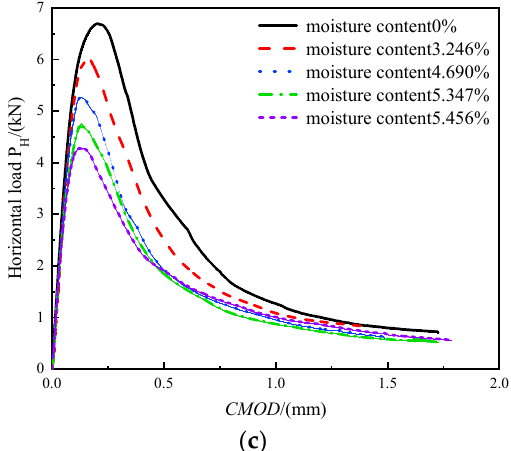
Figure 6. Typical P H –CMOD curve of concrete with different moisture content and strength grade. ( a ) P H –CMOD curve of C20 concrete ( b ) P H –CMOD curve of C30 concrete ( c ) Typical P H –CMOD curve of C40 concrete.